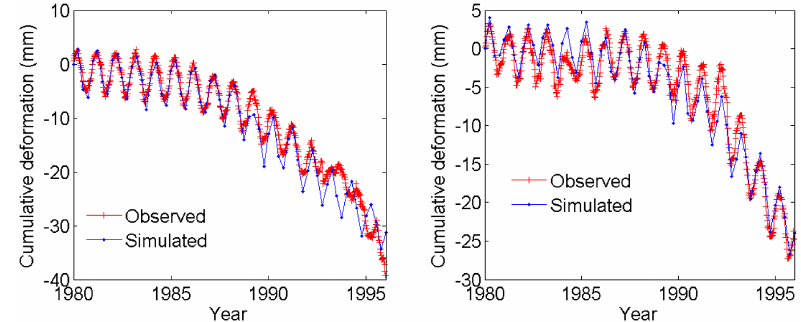
Figure 6. Simulated and measured vertical deformation (negative values mean compaction) for two depth intervals at the F10 extensometer. (a) 165–294m depth range; (b) 26–78m depth range.